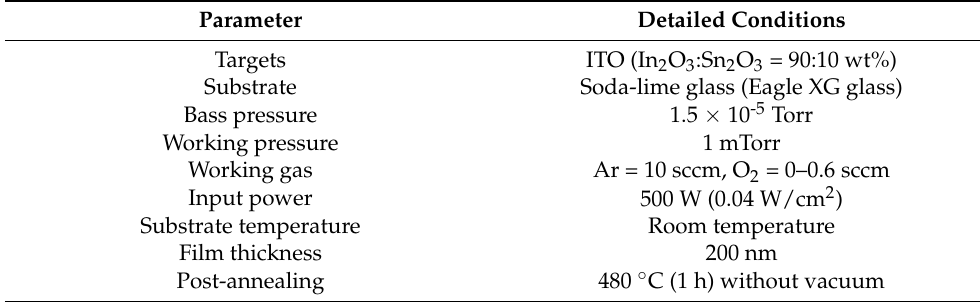
Table 1. Sputtering conditions of ITO